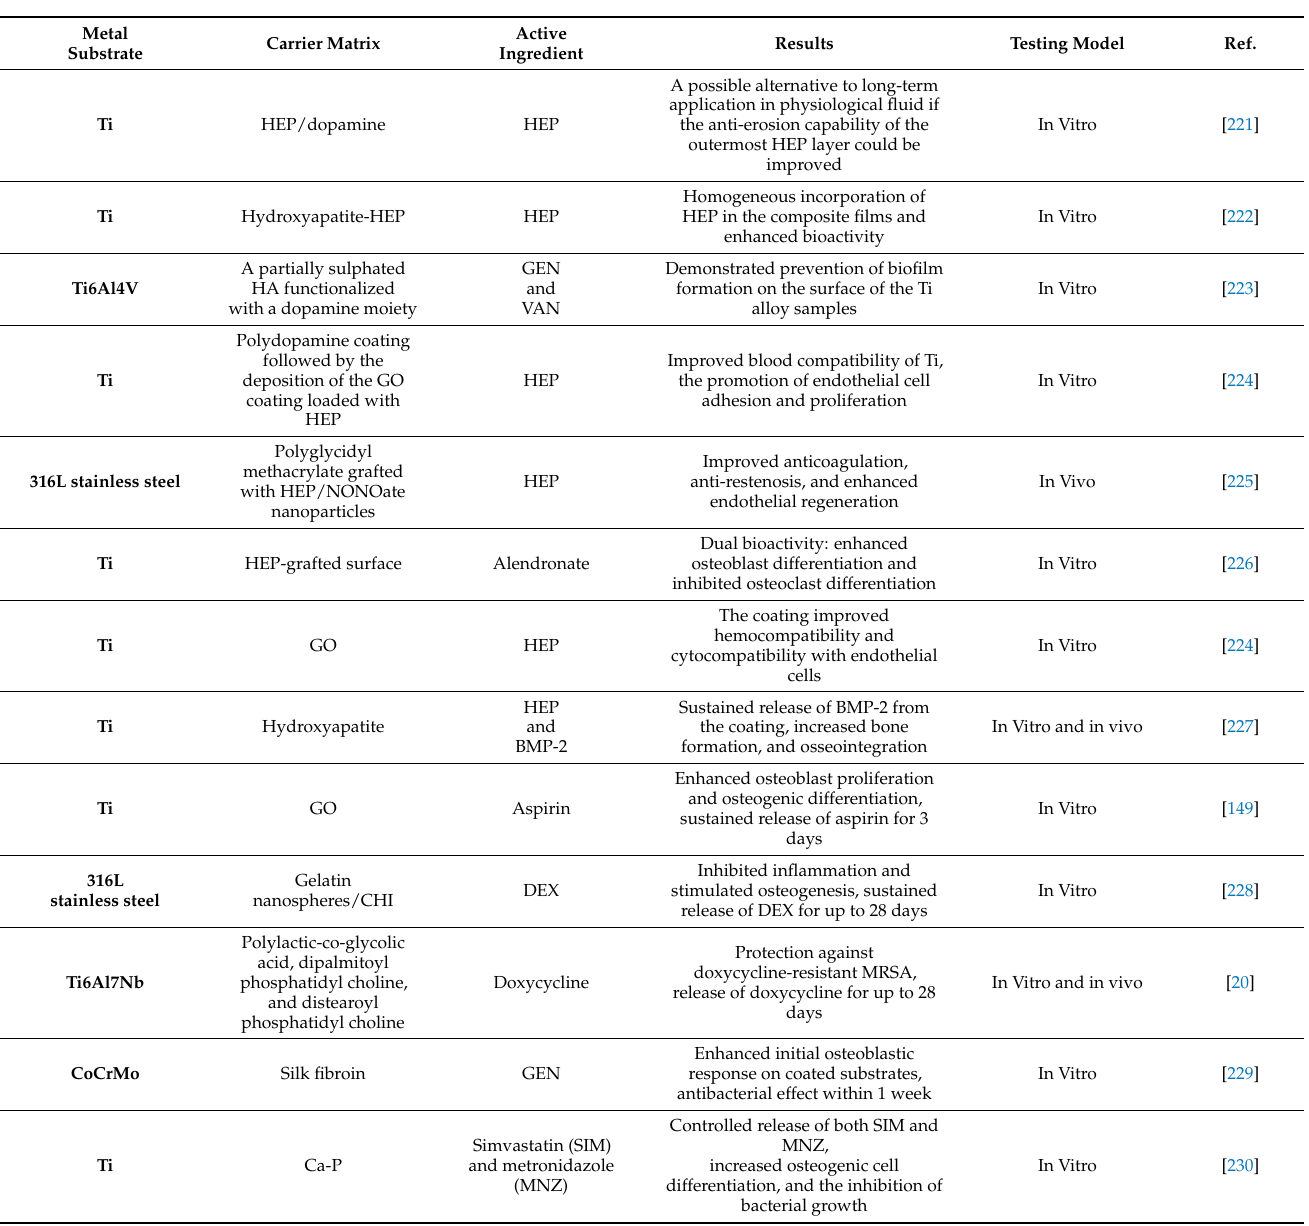
Table 8. A summary of the recently developed bioactive coatings on metal substrates that address some of the bioactivities outlined in Section